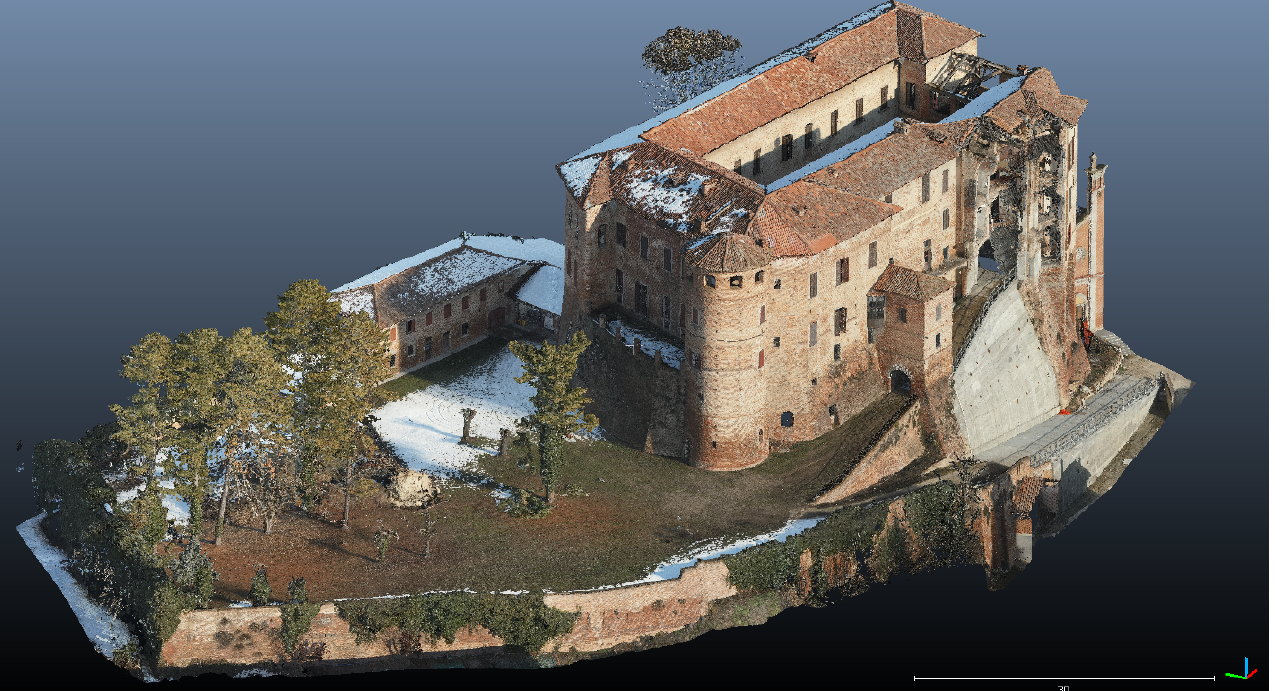
Figure 7. Photogrammetric clouds of the entire castle and surroundings (point dimension 1